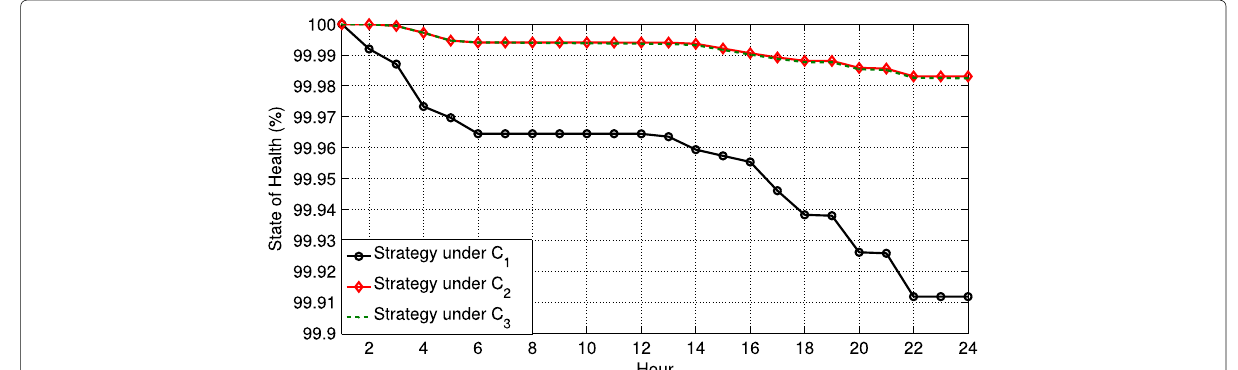
Fig. 9 Average battery cycle aging of the ideal strategy under the constraint sets C 1 , C 2 , and C